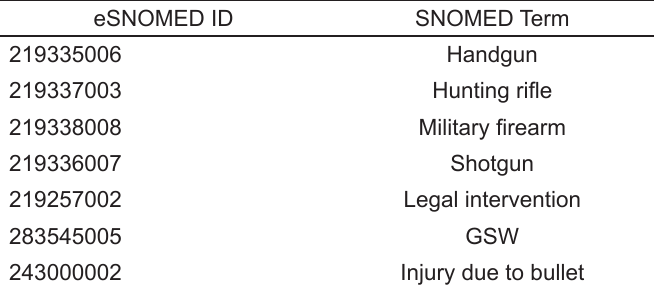
Table 1. Terms for bullet-related injuries from the SNOMED collection of clinical